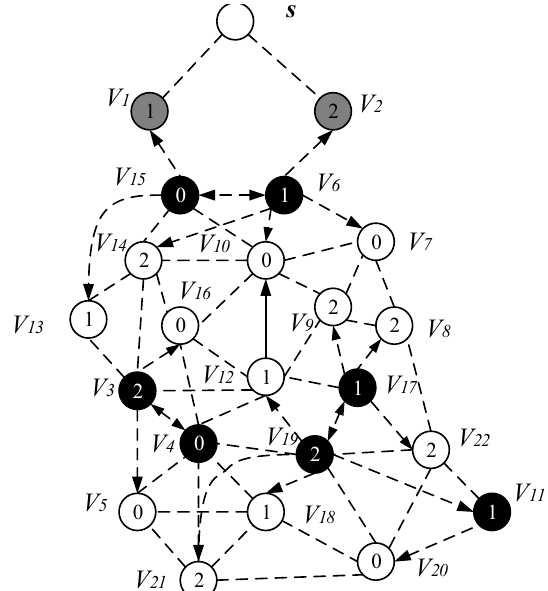
Figure15. Minimum Covering Node Set. Figure 15. Minimum Covering Node